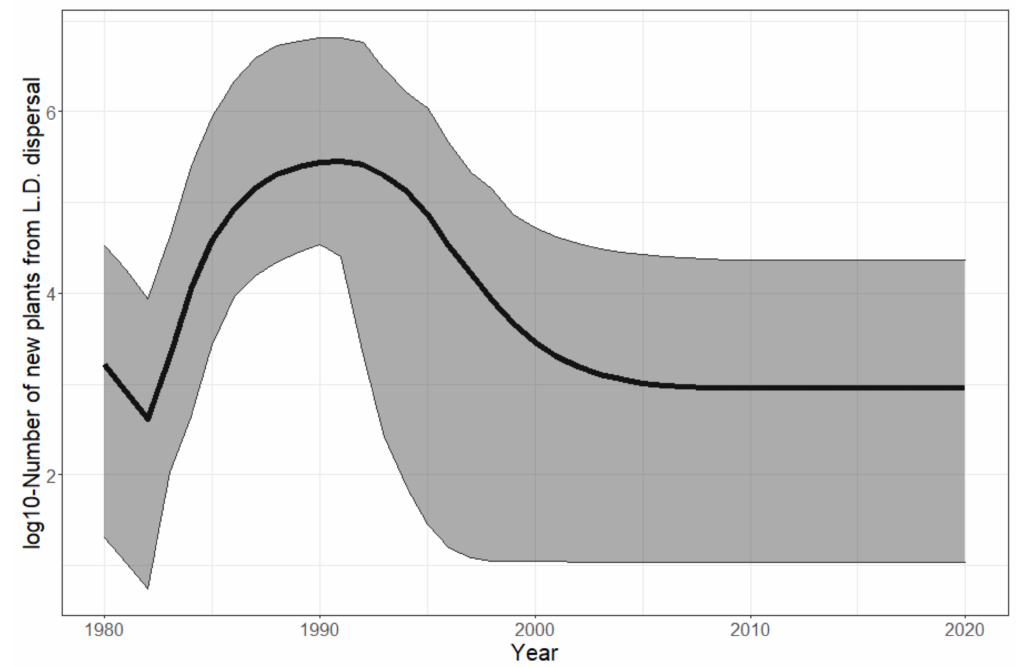
Figure 6. Contribution of long-distance (LD) dispersal to population recruitment over years. The posterior mean (solid curve) of the log10-number of new plants growing from seeds dispersed by long-distance dispersal is shown with its 95% confidence interval (grey ribbon) for each year.